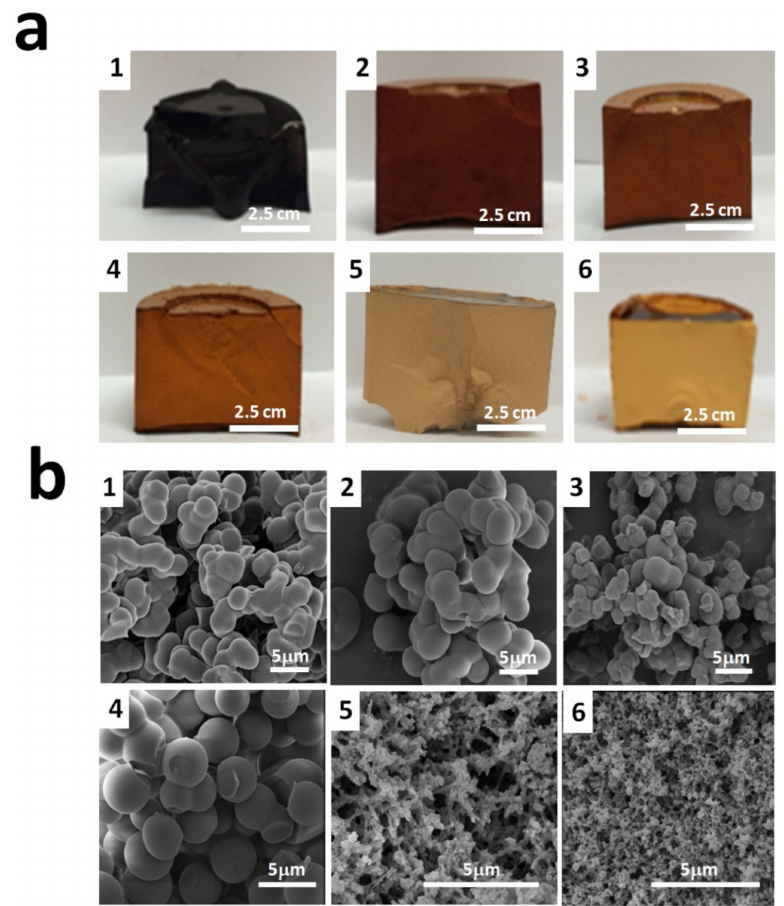
Figure 3. ( a ) Optical photos and ( b ) SEM photomicrographs of RFX–Cs-0 through RFX–Cs-5 samples (numbered as 1 through 6,